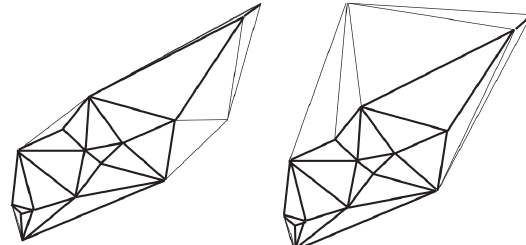
Figure 6: Graph isomorphism of the Delaunay graphs of the matched points on both World View and SPOT6 patch number seven for distance threshold of 2.5. The Delaunay edges with the highest width are isomorphic. The edges with the lowest width are not isomorphic. The subgraphs corresponding to the Delau- nay edges of highest width are isomorphic. The percentage of subgraph isomorphism is 33 =82.5 % 40